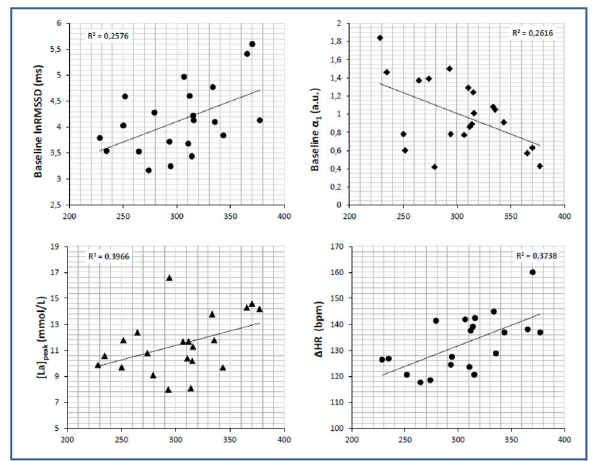
Figure 2. Relationship between BSJT different variables ( y-axis ): [La] α . Linear regression (R 2 ) is included. 1